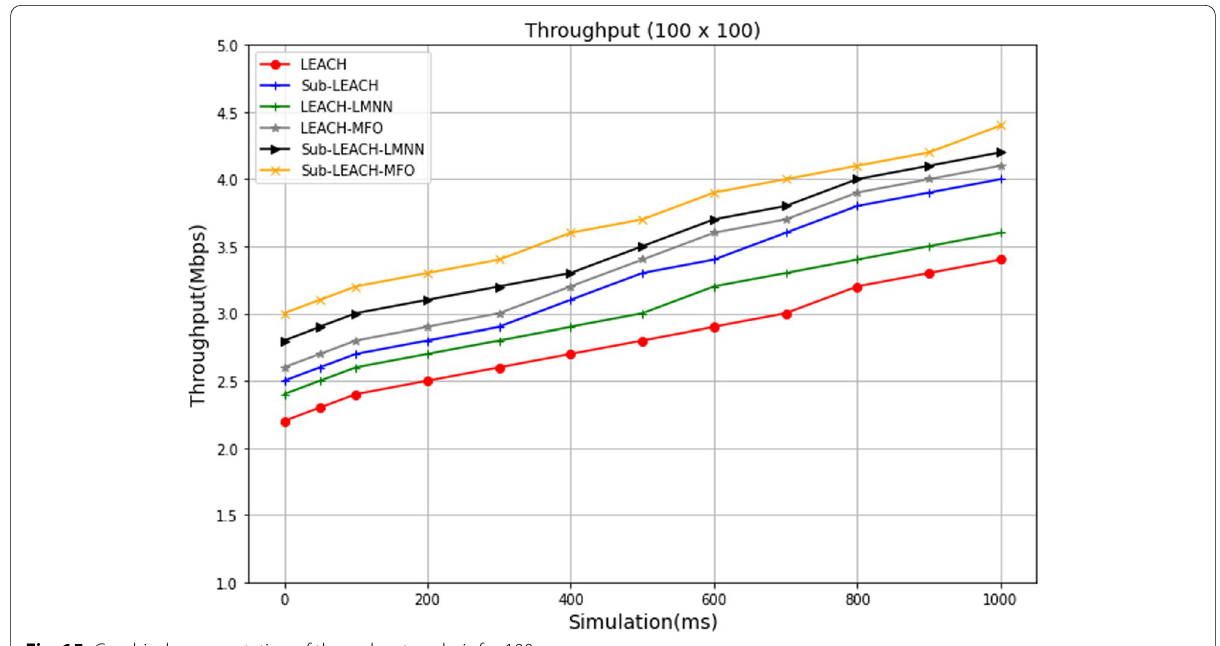
Fig. 15 Graphical representation of throughput analysis for 100m